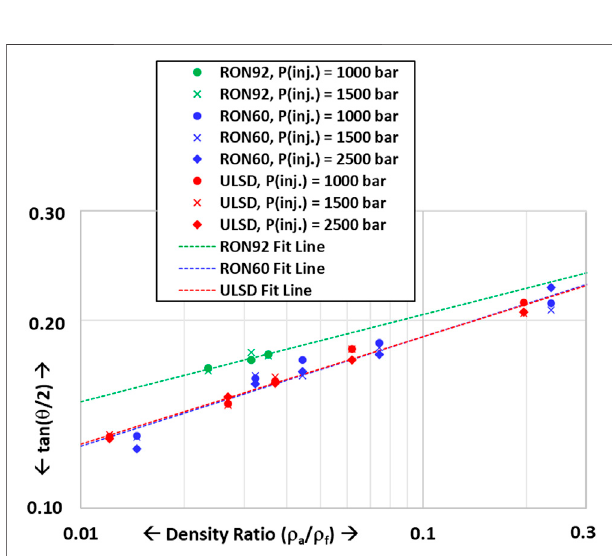
FIGURE 13 | Tangent of non-vaporizing dispersion half-angle vs. density ratio.